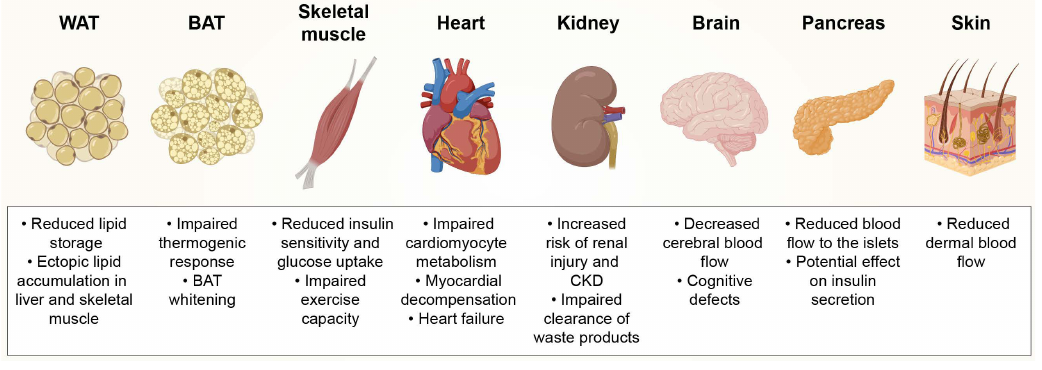
Figure 1. Consequences of obesity-induced capillary rarefaction on tissue function. White adipose tissue (WAT), brown adipose tissue (BAT), chronic kidney disease